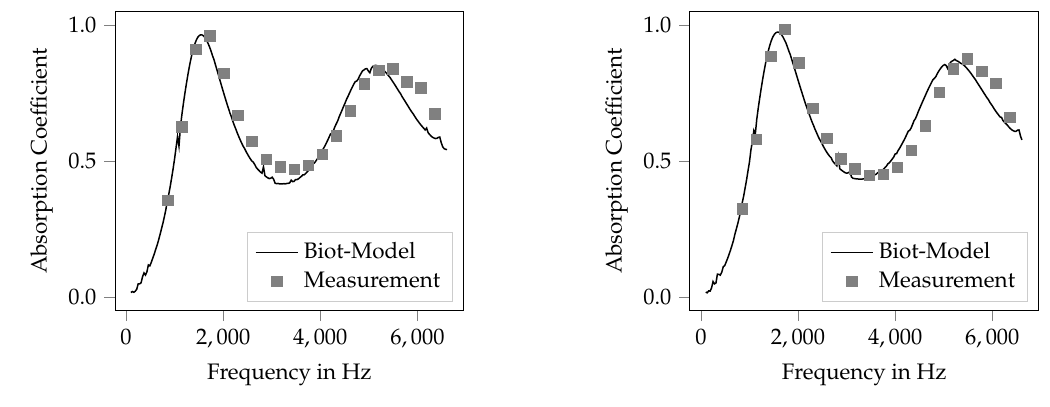
Figure 5. Verification of the inverse parameter identification by applying the identified B IOT -parameters to specimen with l =